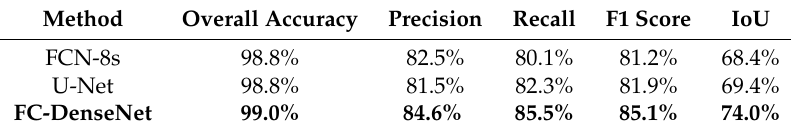
Figure 9. Three examples ( a – c ) represent the building detection results from three CNNs: FCN-8s, U-Net, and FC-DenseNet. Table 4. Statistical accuracy of building detection results among different